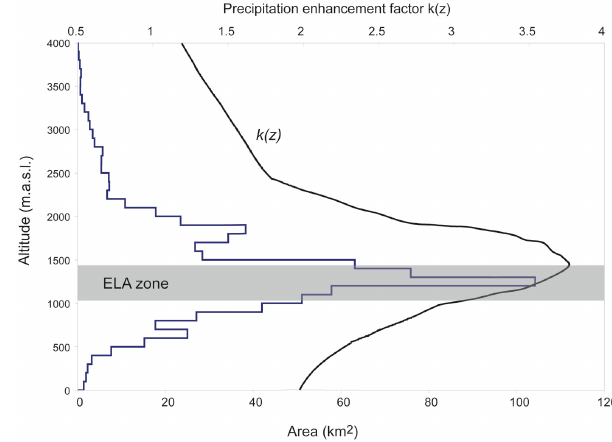
Fig. 7. Year 2000 AD area-altitude distribution of Glaciar San Rafael, in 100-m. altitude intervals, derived from SRTM data, and spatial variation in the precipitation enhancement factor k(z) (black line) used to model precipitation on the glacier surface. The en- hancement factor is a multiple of precipitation at the coast. The zone of equilibrium line altitudes from 1960–2005 is indicated by the grey